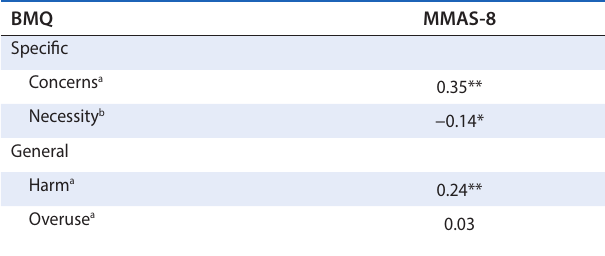
Table 5: Correlation of MMAS-8 and BMQ values